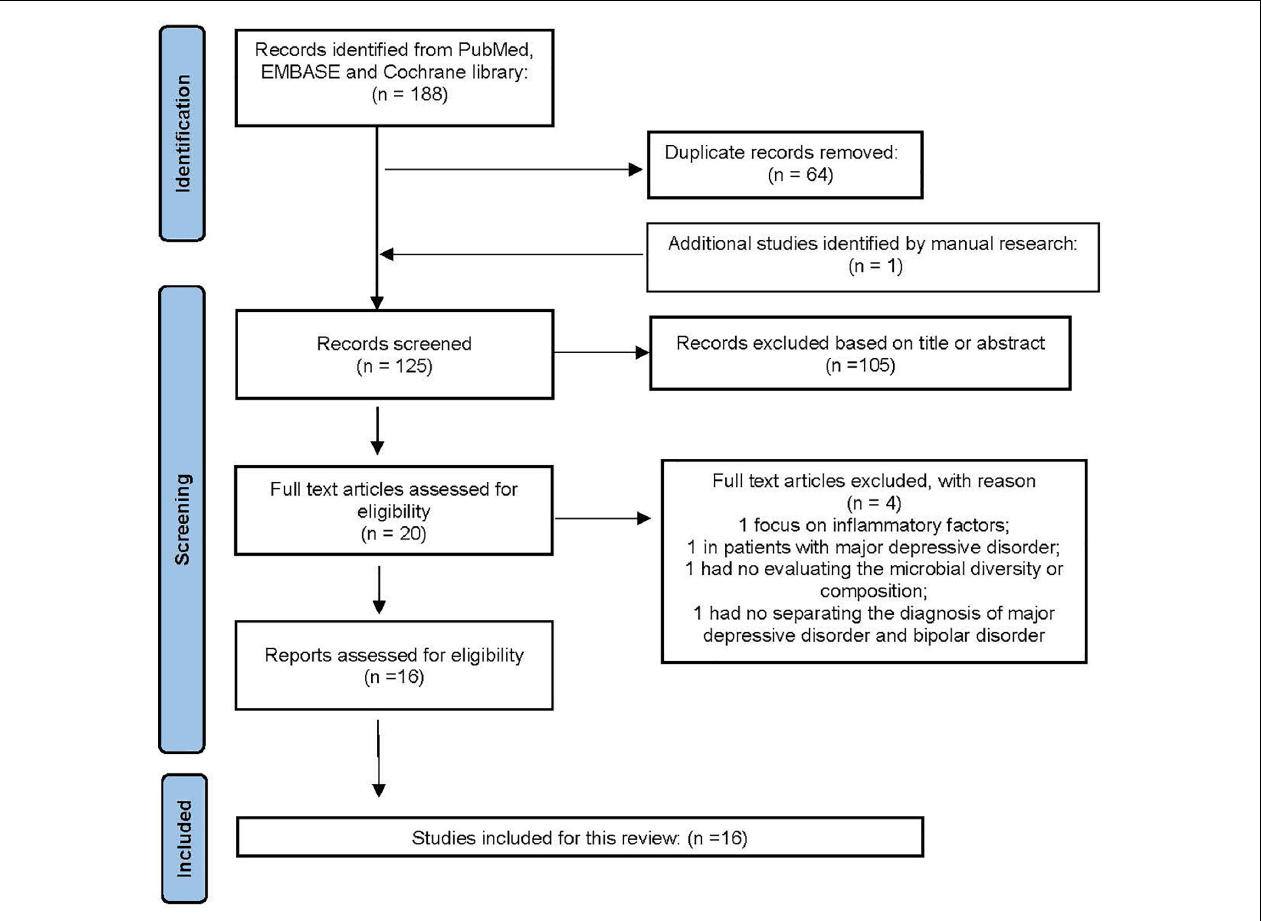
FIGURE 2 | The PRISMA flow